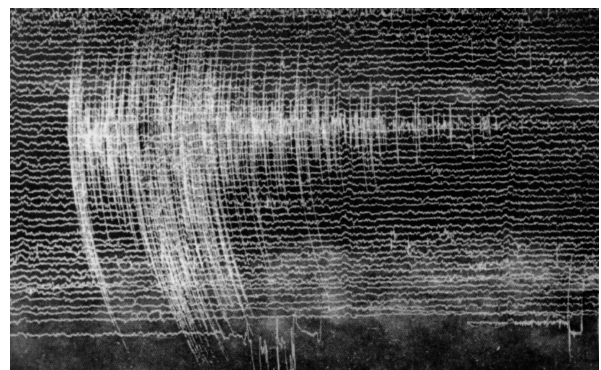
Figure 12. Seismogram registered at the site of Myllytulli, Oulu, witnessing an earthquake that took place in Hautajärvi, Salla, north- eastern Finland, on 20 February 1960 (photo supplied by Heikki